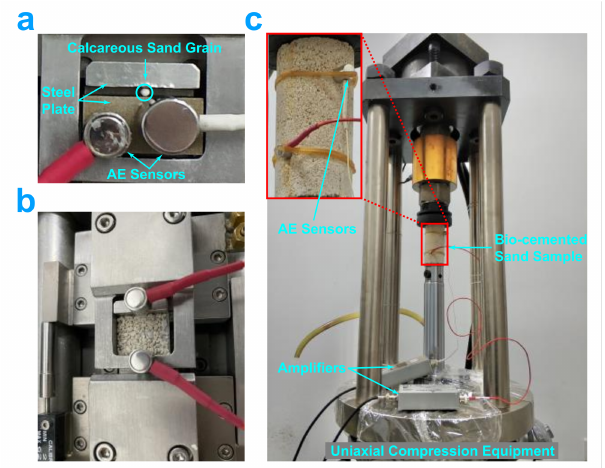
Figure 9. Compression arrangement for ( a ) grain, ( b ) sands without cementation, and ( c ) biocemented sand sample crushing. Reproduced with permission from [77]. Elsevier,